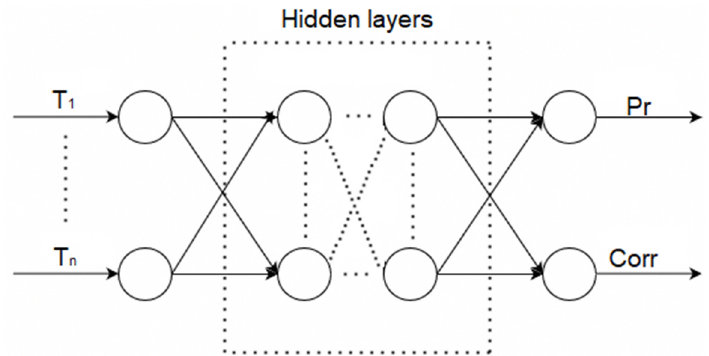
Figure 6. General structure of an artificial neural network for the identification of errors, where T 1 , ..., T n are input data, which are time-series data from the brazing process, i.e., the temperature of one of the brazed elements, Pr is the output class, indicating the presence of an error, and Corr is the output class, indicating the normality of the error.